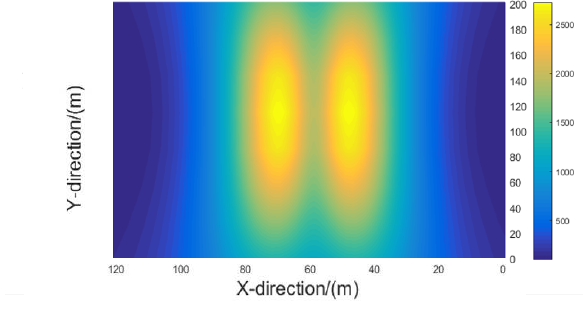
Figure 9. The 3D calculation method results of finite element method